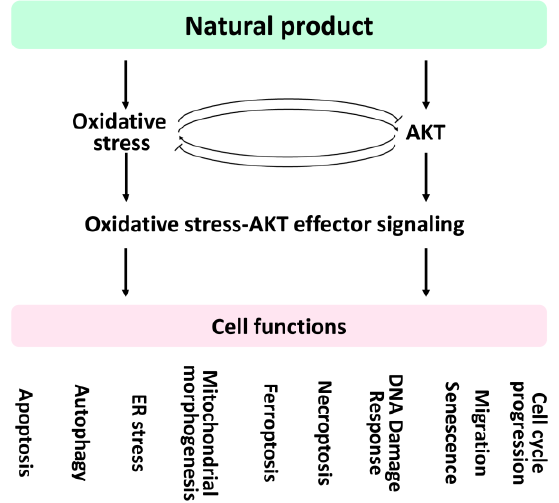
Figure 2. Hypothesis: Natural products modulating oxidative stress and the AKT pathway (AKT and AKT effectors) regulate several cell functions. The oxidative stress-AKT effector signaling is shown in Figure 1. Detailed future works are warranted to assess additional cell functions that are affected by natural products for anticancer treatment.